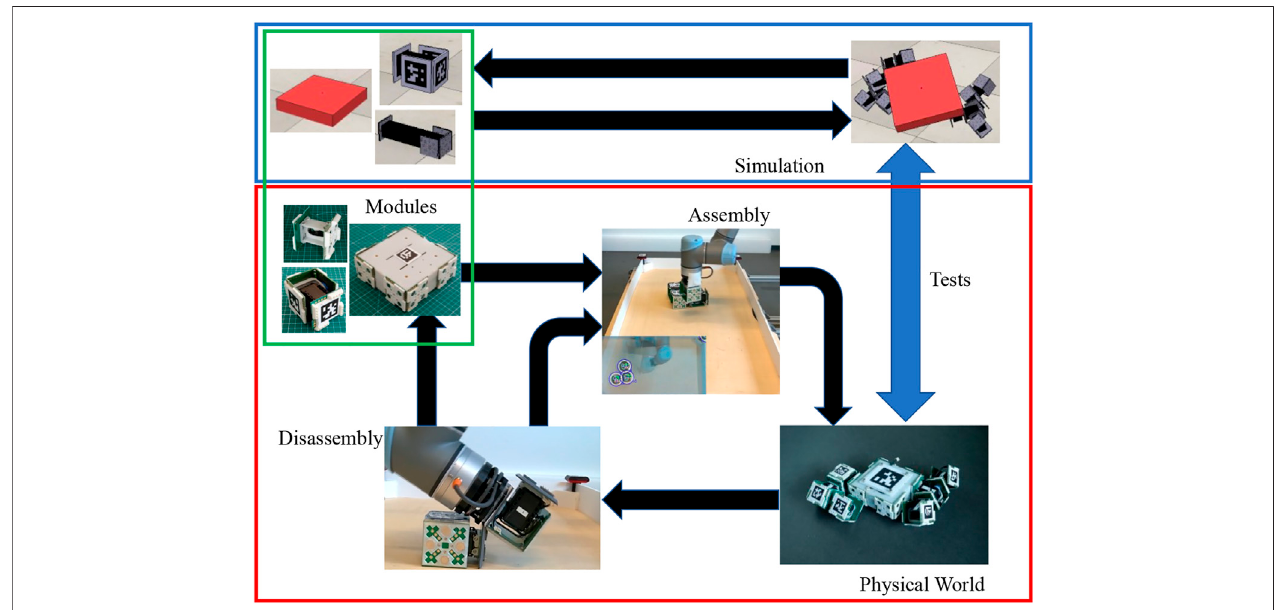
FIGURE 1 | Automatic evolution of morphology in full cycle recon fi gurable hardware, with assembly disassembly process, for the EMERGE system using a manipulator with a passive gripper. A set of EMERGE modules is assembled using a robot manipulator with a passive magnetic gripper. The assembled morphology is tested and then disassembled by the same manipulator. The disassembled modules can be stored or reassembled in a new morphology. The system can run an evolution in hardware or use a mixed approach by using results from a simulation.